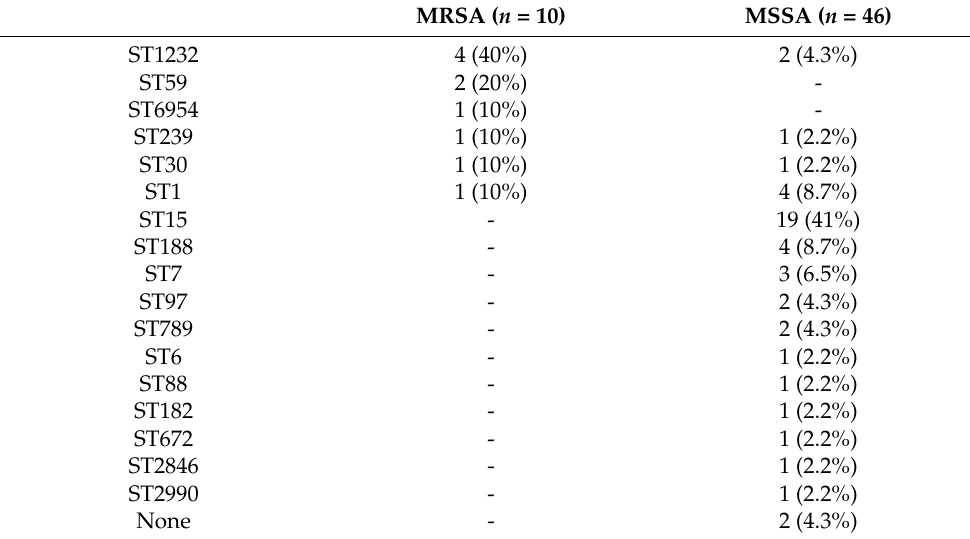
Table 4. MLST of the S. aureus isolates in the grey